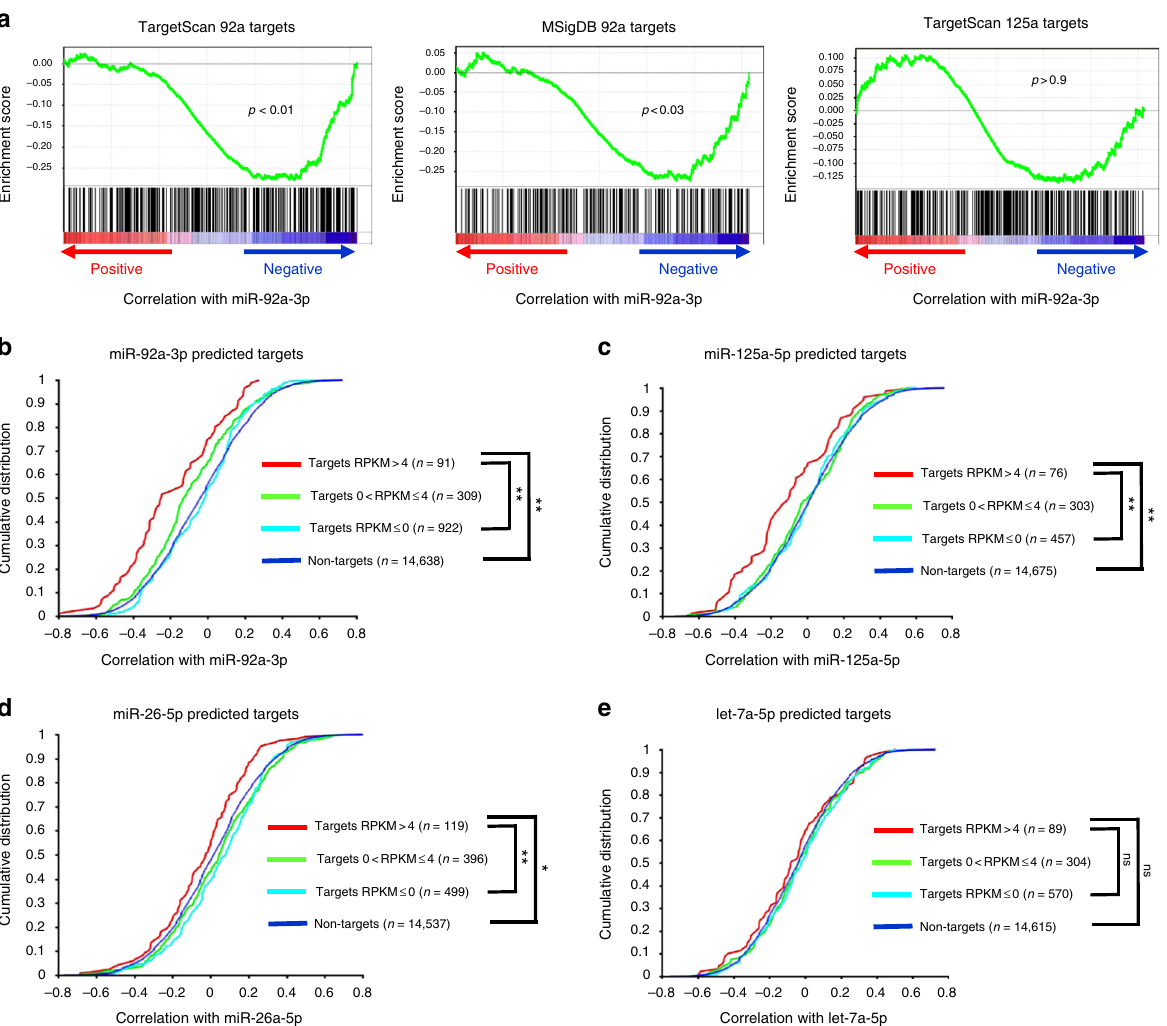
Fig. 4 Relationships between miRNA and miRNA targets in paired half-cell data. a mRNAs were ranked according to their correlation with miR-92a-3p using data from the 19 pairs of half-cell miRNA and mRNA pro fi les. The resultant rank list was queried with predicted targets of miR-92a-3p obtained from TargetScan or MSigDB (left and middle panels) or with targets of miR-125a-5p from TargetScan (right panel). Gene set enrichment analysis plots are shown with P- values indicated. b – e mRNAs were ranked according to their correlation with b miR-92a-3p, c miR-125a-5p, d miR-26a-5p, or e let-7a-5p. Cumulative distribution functions were plotted with non-targets and with predicted targets of the corresponding miRNA (based on TargetScan). Predicted targets were further categorized based on the mean RPKM values across the 19 K562 half-cell samples. The number of genes in each category is indicated in parentheses. P- values were calculated based on the Kolmogorov – Smirnov test between the indicated pairs of conditions. ** P < 0.005; * P < 0.05; ns